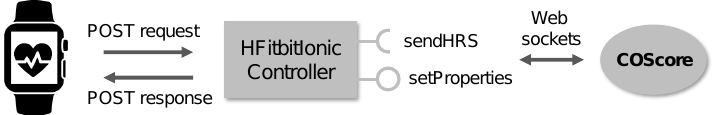
Figure 5. HFitbitIonicController component implementing the